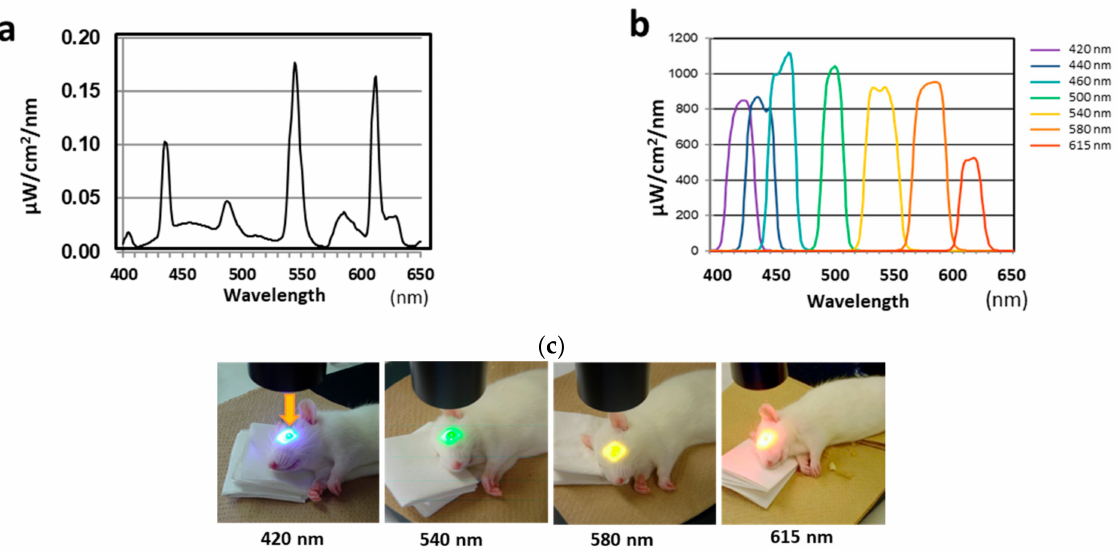
Figure 5. Spectral distributions of white fluorescent light from a xenon lamp and rats exposed to light. ( a ) Spectral distribution of white fluorescent light. ( b ) Spectral distribution of light from a xenon lamp source. ( c ) Rats exposed to light of different wavelengths. Arrow indicates the direction of the exposed visible light.